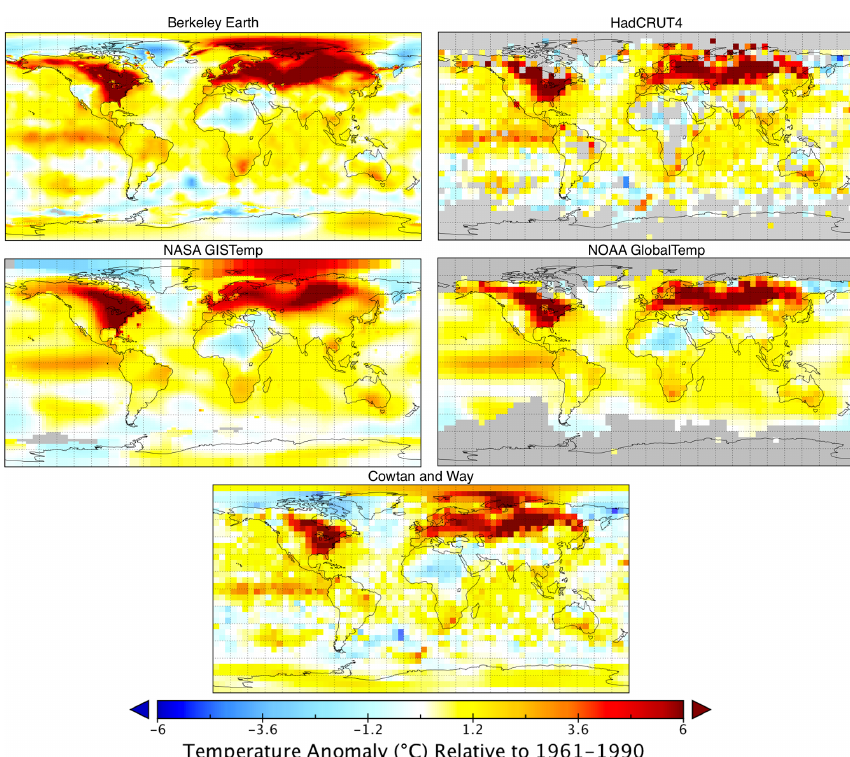
Figure 4. Global gridded temperature anomalies for December 2015 relative to a 1961–1990 baseline for each global temperature dataset. Grid resolution is based on the highest-resolution dataset provided by each group: 1 ◦ × 1 ◦ lat–long for Berkeley Earth, 5 ◦ × 5 ◦ for HadCRUT4,